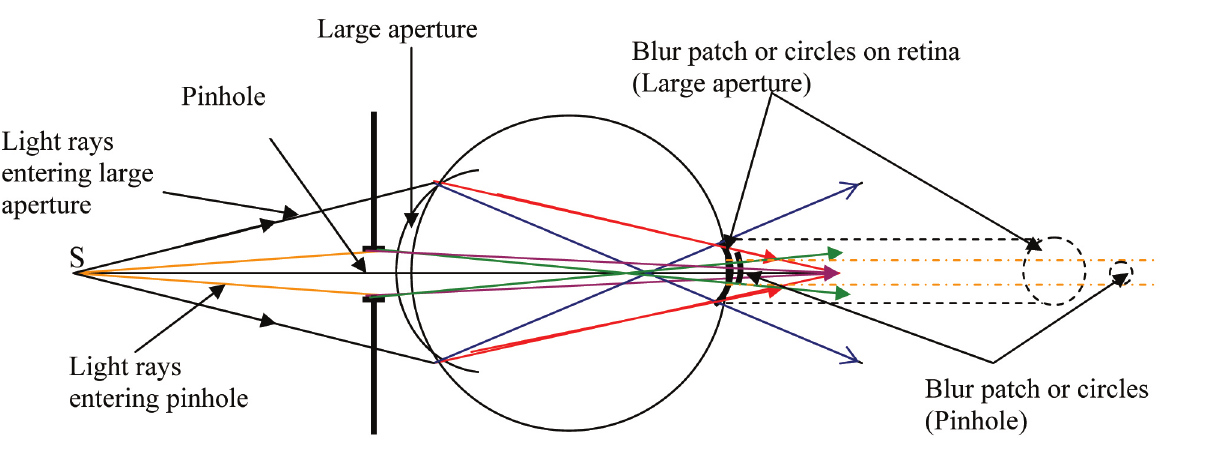
Figure 13 . Light from a point source S enters the eye, firstly through a large circular aperture (black lines). After refraction the converging pencil may form a focus in front of or behind the retina. If in front (blue lines) the pencil continues to diverge away from the point focus towards the retina and forms a blur patch or circle on the retina. The shape of the blur patch is a result of the aperture being circular in shape. The size of the blur is determined by the marginal rays of the pencil that reach the retina. The same will apply if the pencil, after refraction forms a focus behind the retina (red lines). It can be seen that if a smaller aperture is placed in front of the eye (pinhole), the marginal rays of the pencil after refraction form a smaller blur patch on the retina thus reducing the blur (green and purple lines) and thus increasing the depth of